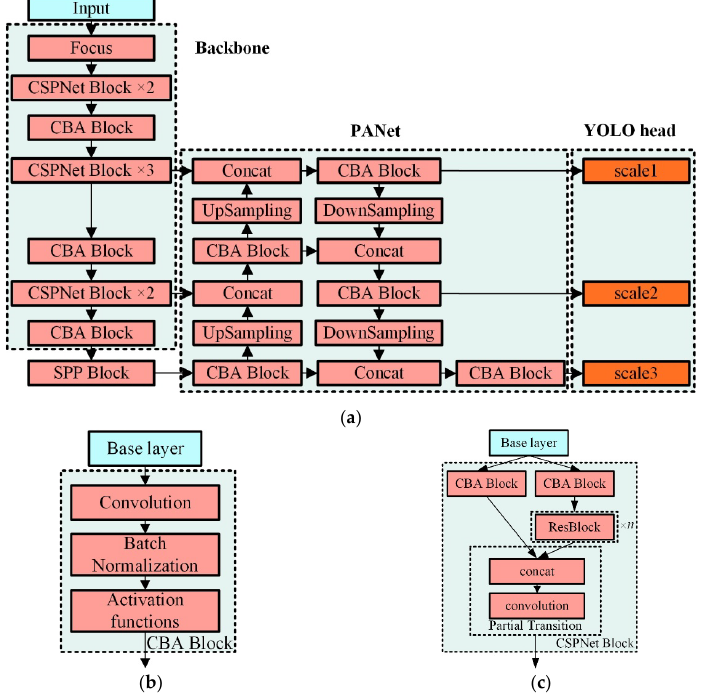
Figure 6. Feature extraction network and main components: ( a ) Improved YOLO-A30 network architecture; ( b ) CBA block component; ( c ) CSPNet block component.